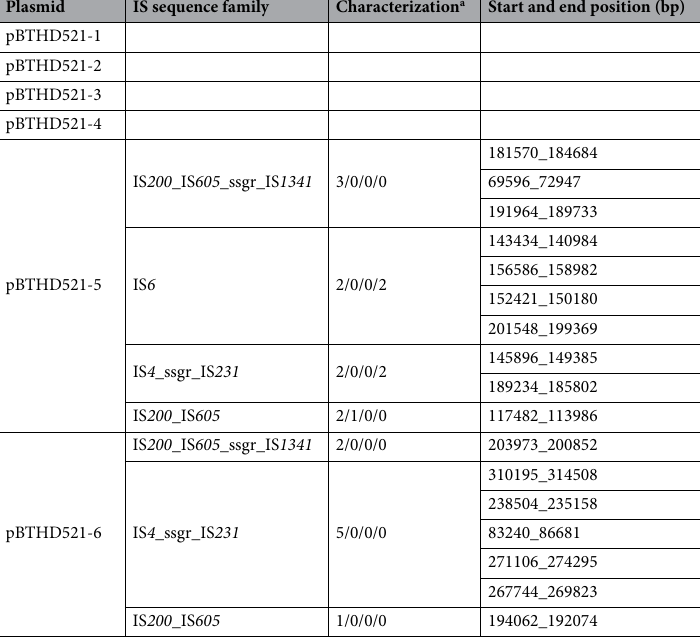
Table 4. The total varieties and quantities of IS sequences in HD521 plasmids. a Complete sequence/partial sequence/pseudogenes/unknown